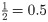
Schematic illustration of the probable coevolving process of common interests and trust relations in this paper.Suppose there are a pair of users, say user u and user v, and four reviews as the items. We assume that the items both user u and user v commented are the common interests for them. At Initial state, both user u and user v comment item 2 as well as user u also comments item 1. The overlap between the two users equals the ratio for the numbers of the items commented by user v and user u, i.e., 12=0.5. At Final state, the value of overlap between the two users has increased to 23=0.67 since both of them commented item 4. Meanwhile, user u has trusted user v. However, there are two probable ways for the two users to reach the Final state from the Initial state, say Path a and Path b. Path a indicates that the increment of the common interests between users can bring new trust relation; Path b implies that the creation of trust relation is the reason for users to have more common interests.